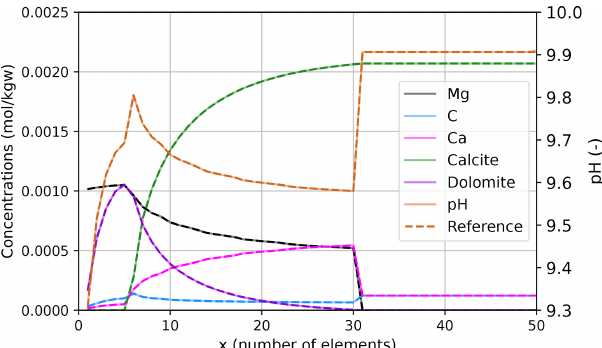
Figure 2. Concentration, pH and mineral profiles comparing the TRANSPORTSE-PHREEQC simulation results against the ref- erence 1D transport model introduced by Engesgaard and Kipp (1992), where a MgCl 2 solution enters the model via the left bound- ary, with mineral dissolution and precipitation being controlled by reaction